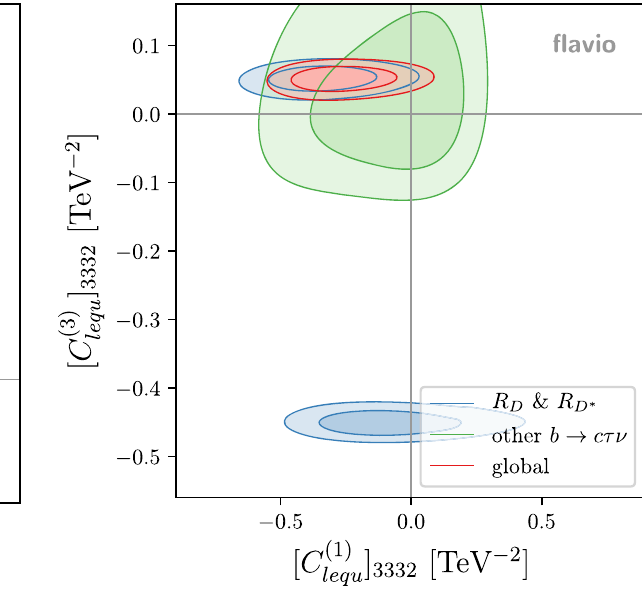
Fig. 4 Left: likelihood contours in the space of b → c τν τ WET scalar and tensor operator from R D and R D ∗ (blue), the combination of B c → τν , B → D ( ∗ ) τν differential rates and F L ( B → D ∗ τν)